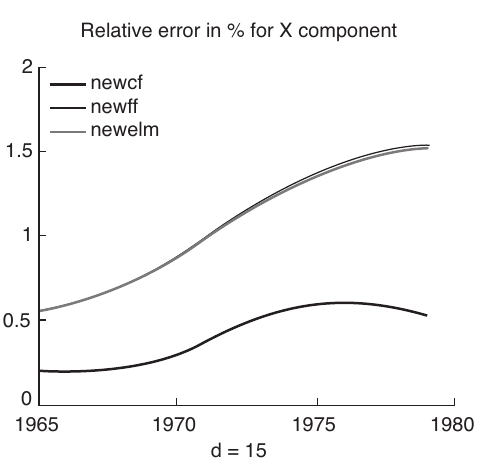
Fig. 2. Variation of absolute error prediction by the input dimension